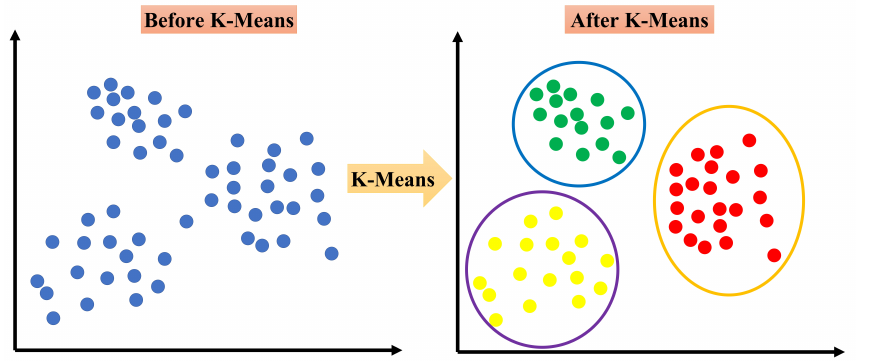
Figure 5. K-means clustering.